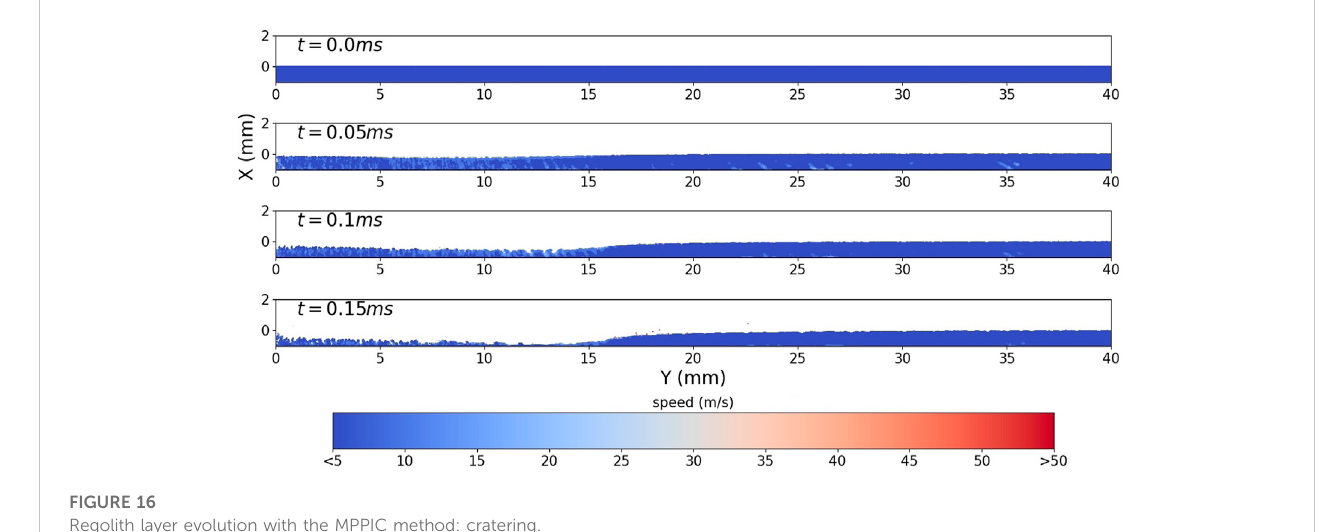
distorted by the solid particle distribution, as shown in Figure 10, where a secondary vortex was also observed in the gas phase at later times. It can be noted that some solid particles are lifted between Y = 11 mm and Y = 15 mm and form wave-like structures in Figure 18 by